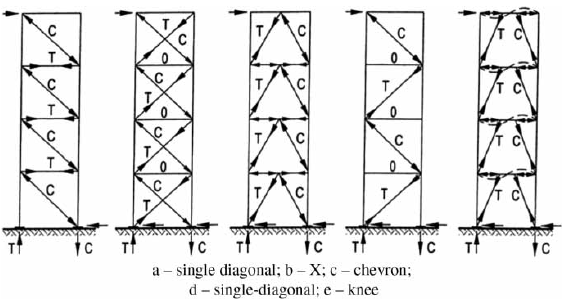
Fig. 6. Load path for horizontal shear through web members of CBF systems (Taranath